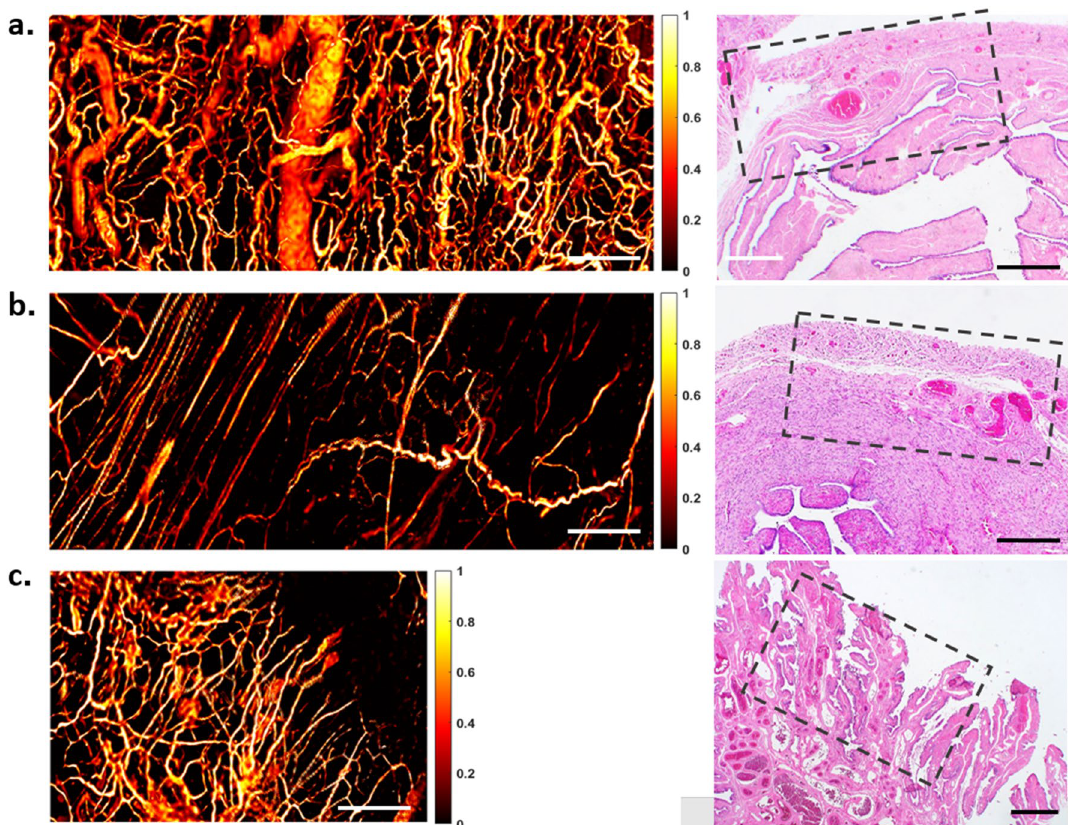
Figure 3. Vasculature of normal fallopian tubes and the representative H&E histological images: ( a ) the isthmus, ( b ) ampulla, and ( c ) fimbriae. Scale bar: 500 μm.